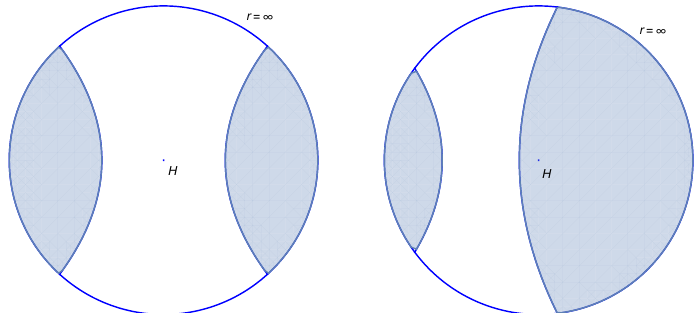
Figure 11 . We consider the case where the (unshaded) SAdS region between two consecutive domain walls contains an SAdS horizon (left). The alternative case where it does not is shown at right. In particular we will focus spacetimes that have a Z 2 re(cid:13)ection symmetry exchanging the two domain walls as shown in the left